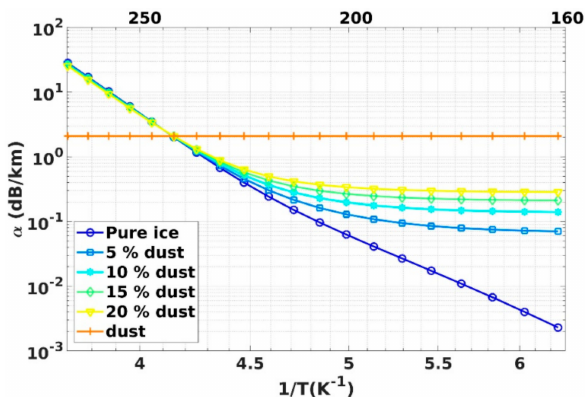
Figure 2. The attenuation coe ffi cient as a function of temperature at 4 MHz for di ff erent materials composing the SPLD.